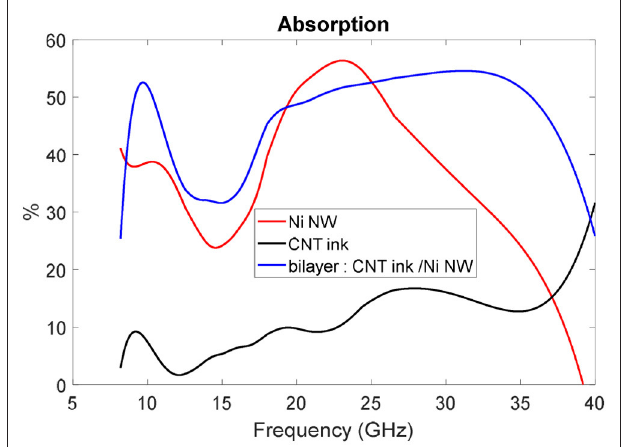
FIGURE 7 | Combination of CNT-layer and Ni NW-layer for improved absorption. The Ni-NW/CNT bilayer is constructed and measured by stacking together a CNT layer and a Ni-NW layer similar to section Nanowires-Based Absorber.